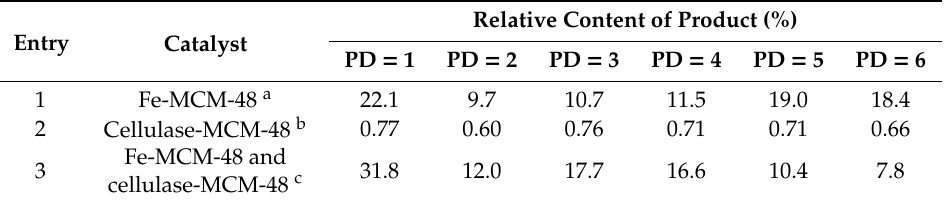
Table 5. Relative content of degradation products obtained from depolymerization of chitosan. PD, polymerization degree.